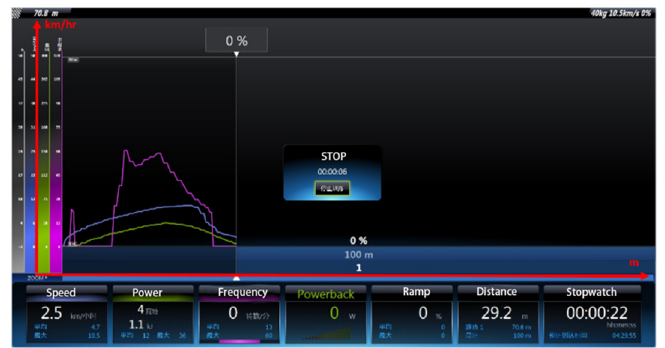
Figure 14. Results for flat road, cyclist weight 40 kg, and lower-arm three-phase short-circuit braking.